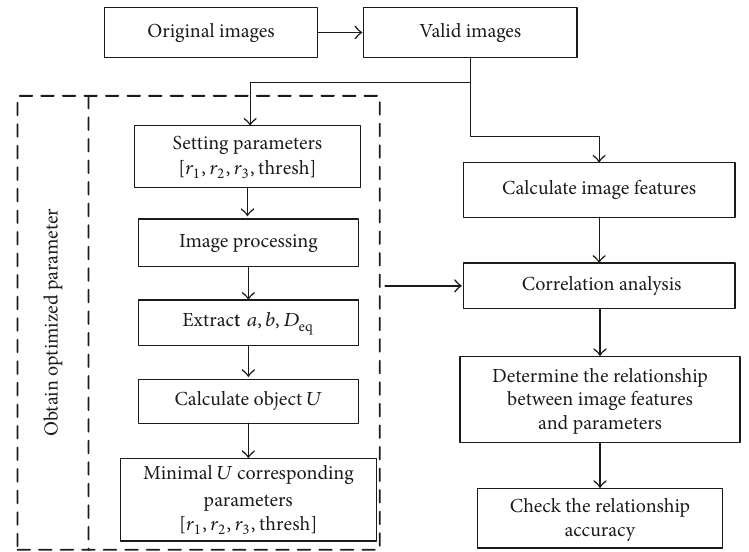
Figure 10: Flowchart of the calibration algorithm.